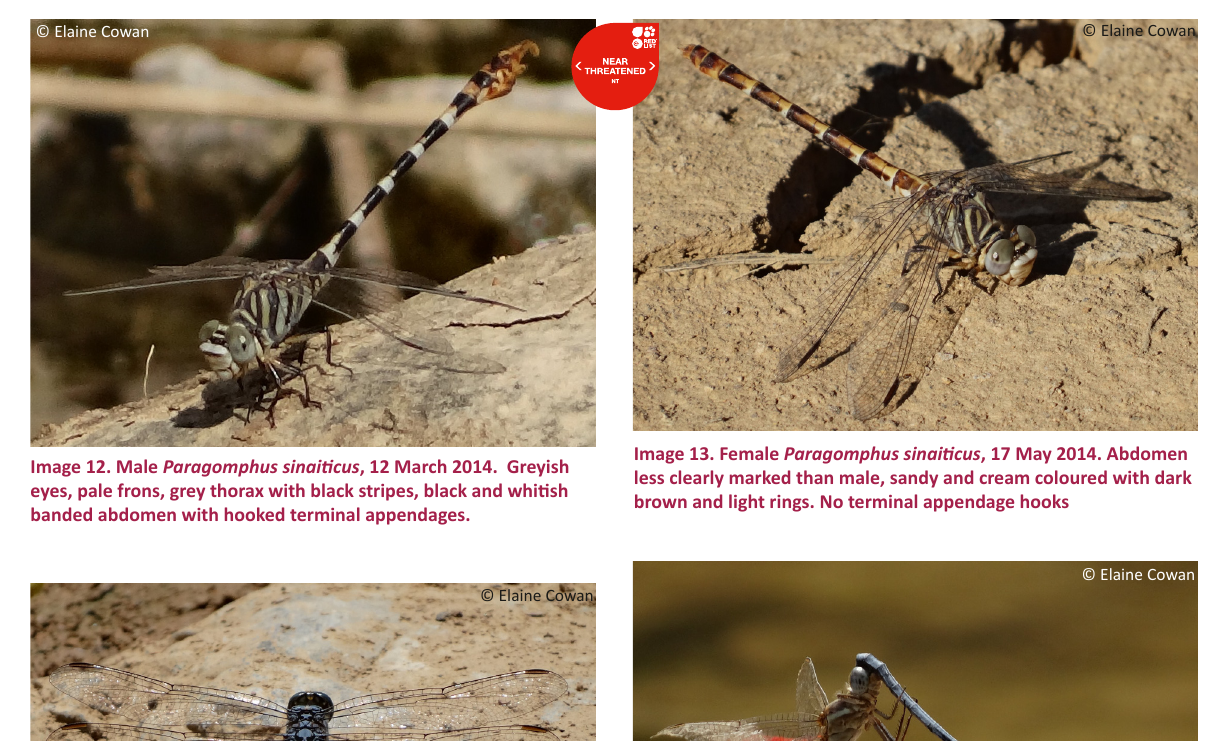
Image 14. Male Orthetrum chrysostigma , 31 March 2014. Blue eyes, blue/black legs, blue thorax. Blue abdomen ‘waisted’ near base